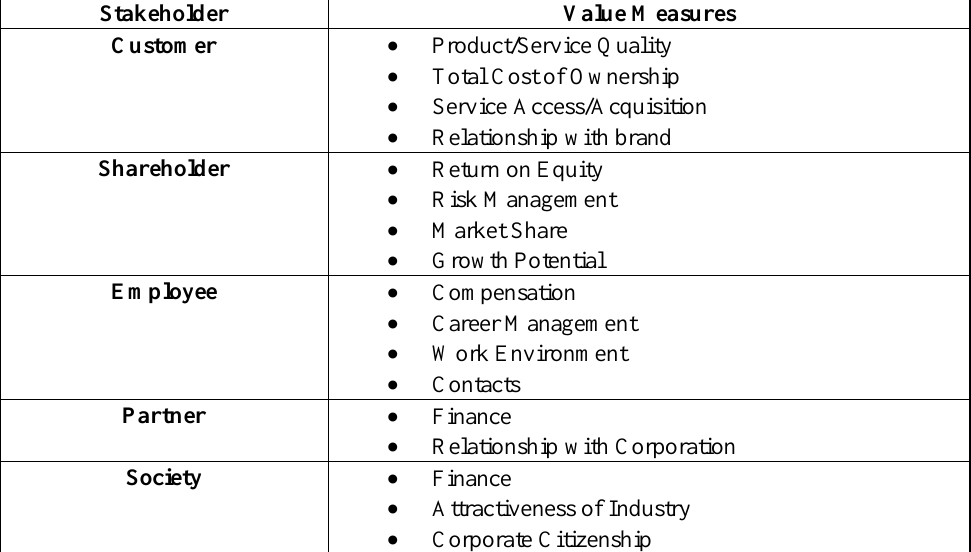
Table 1 . Major categories of stakeholder values